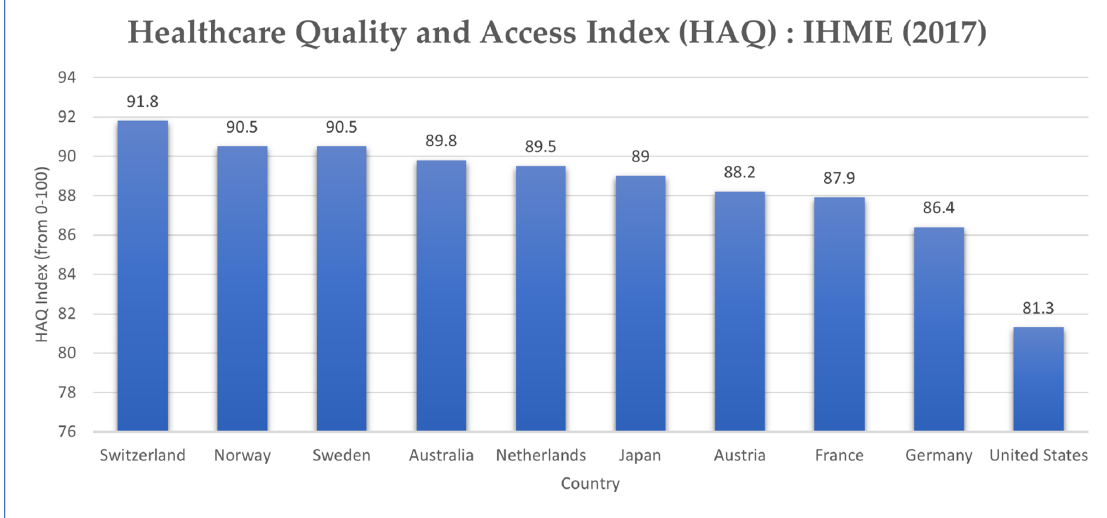
Figure 9. Healthcare Quality and Access (HAQ) Index Rating, 2015(Source: Adapted from Our World in Data) [46].